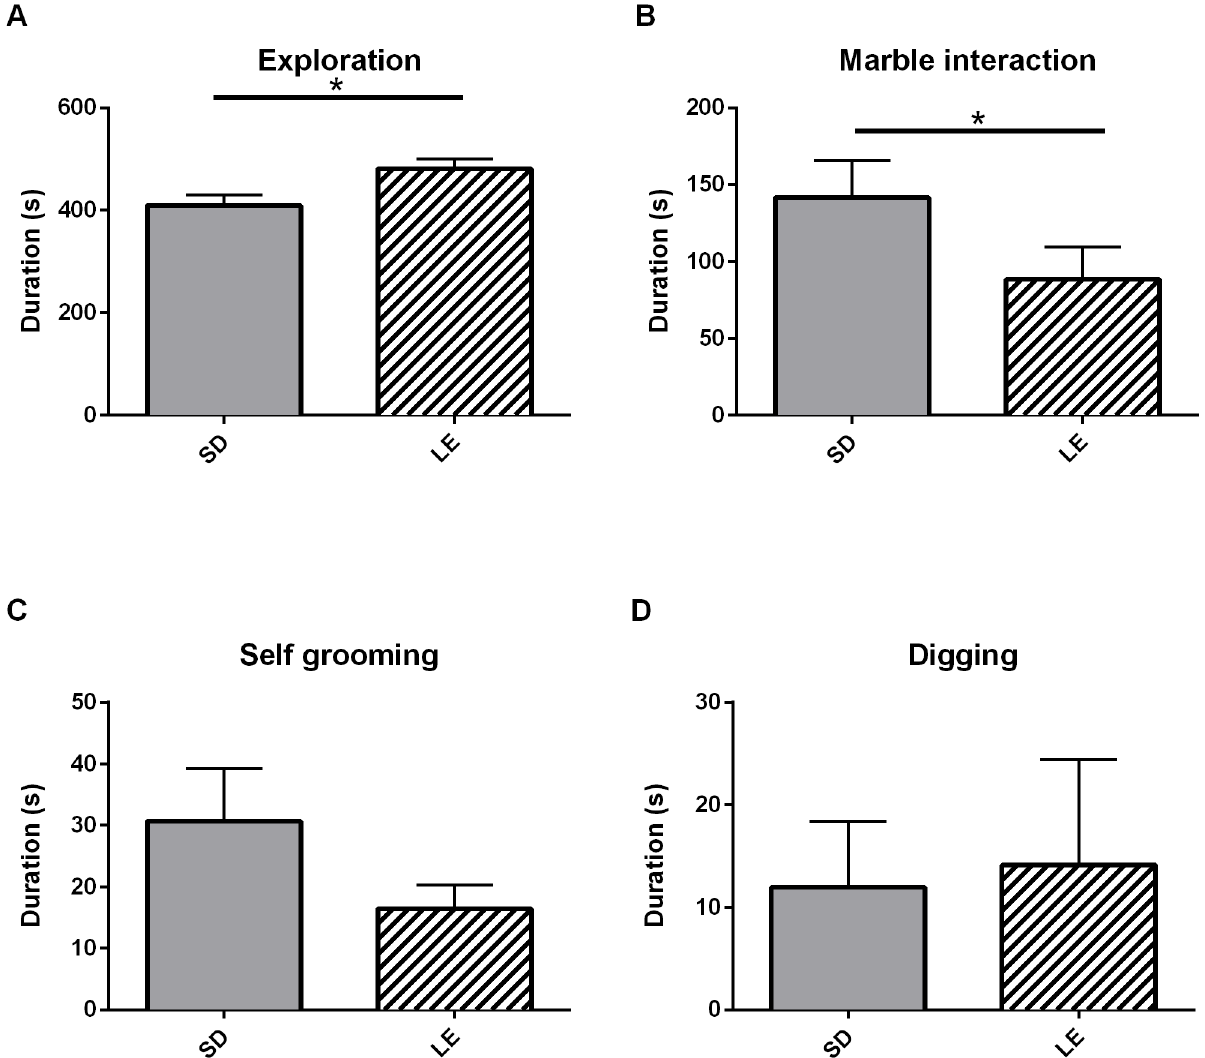
Fig 9. Manually scored behaviors during marble burying. A) SD rats spent less time exploring (rearing plus active exploration of the arena) than the LE rats. B) SD rats also spent more time interacting with the marbles than the LE rats though there were no strain differences in the other parameters of C) self-grooming and D) digging. Data presented are mean